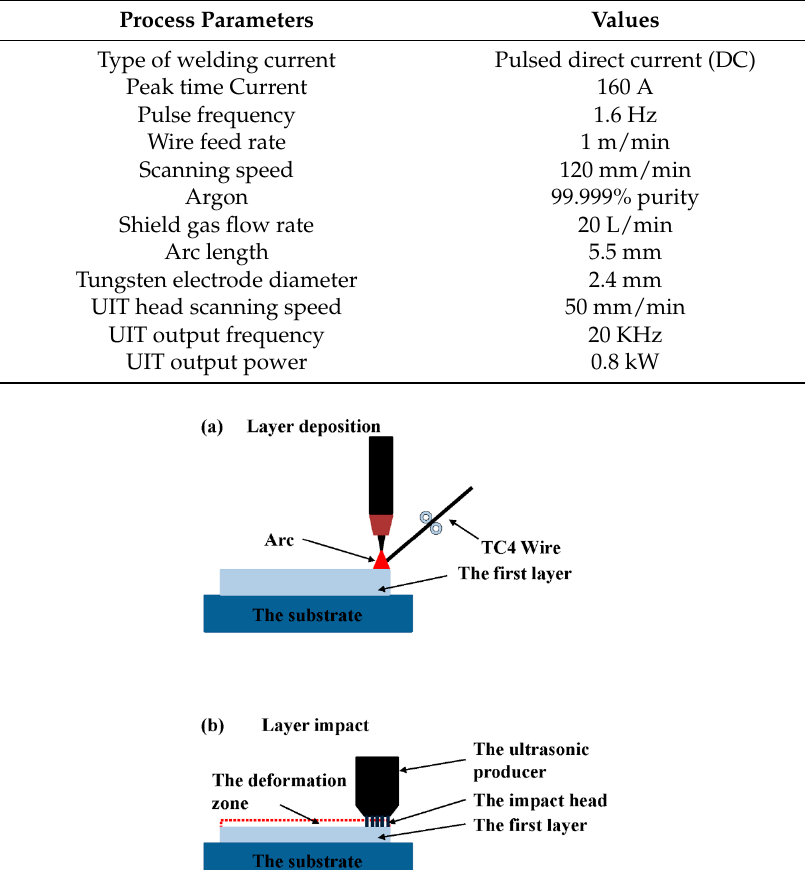
Figure 2. The wire and arc additive manufacturing (WAAM) equipment: ( a ) schematic view of the UIT assisted TIG (Tungsten Inert Gas Welding) deposition system, ( b ) image of the inert atmosphere chamber. Table 1. The process parameters of deposition and ultrasonic impact treatment (UIT).